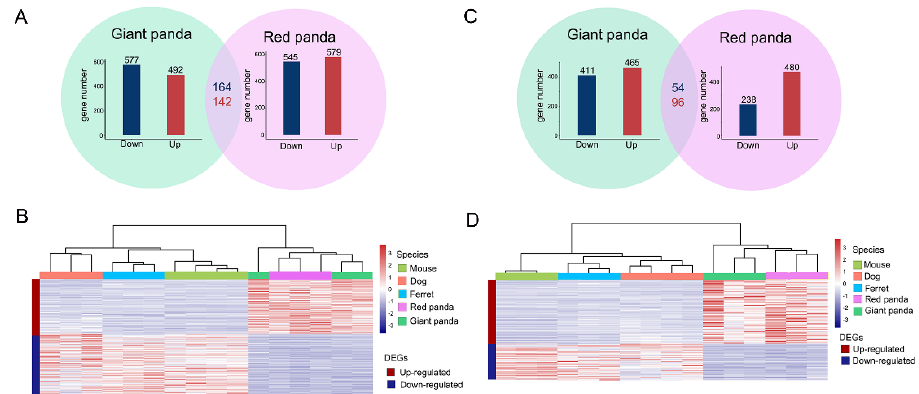
Figure 2. Transcriptional patterns in stomach and small intestine samples. Bar plots in green and purple circles indicate the numbers of DEGs in stomach samples of giant panda and red panda compared with all non-herbivore species, respectively. Numbers in red and blue indicate convergent up- and down-regulated DEGs of two pandas compared with all non-herbivore species in stomach samples, respectively ( A ). The expression levels of convergent DEGs of stomach samples were normalized and log-transformed to draw heat map by adopting hierarchical clustering method ( B ). Bar plots in green and purple circles indicate the numbers of DEGs in small intestine samples of giant panda and red panda compared with all non-herbivore species, respectively. Numbers in red and blue indicate convergent up- and down-regulated DEGs of two pandas compared with all non-herbivore species in small intestine samples, respectively ( C ). The expression levels of convergent DEGs of small intestine samples were normalized and log-transformed to draw heat map by adopting hierarchical clustering method ( D ).